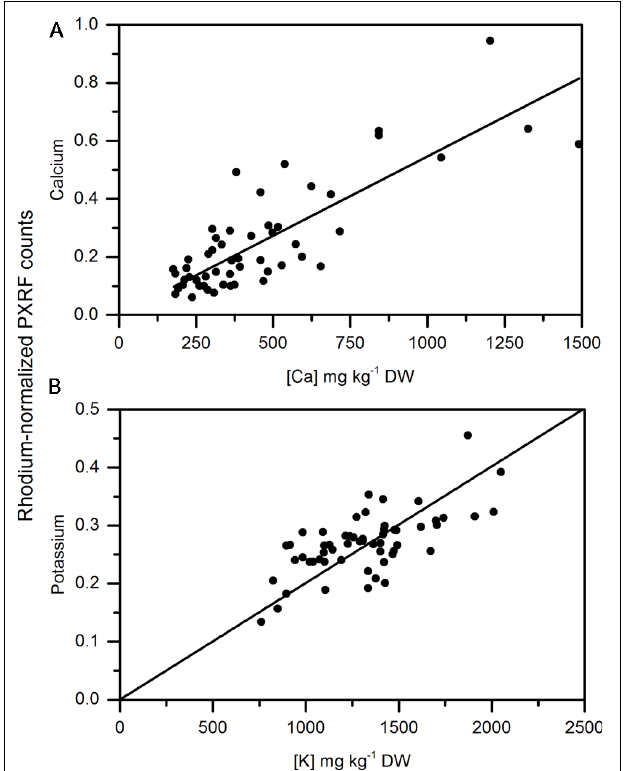
FIGURE 3 | Correlation of non-destructive, semi-quantitative mean (A) calcium and (B) potassium content [mg kg − 1 dry weight (DW)] compared to corresponding MP-AES analysis of calcium in apple peel ( N =